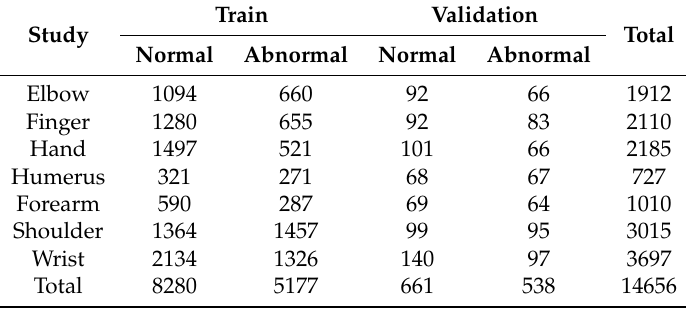
Table 1. Distribution of the MURA data